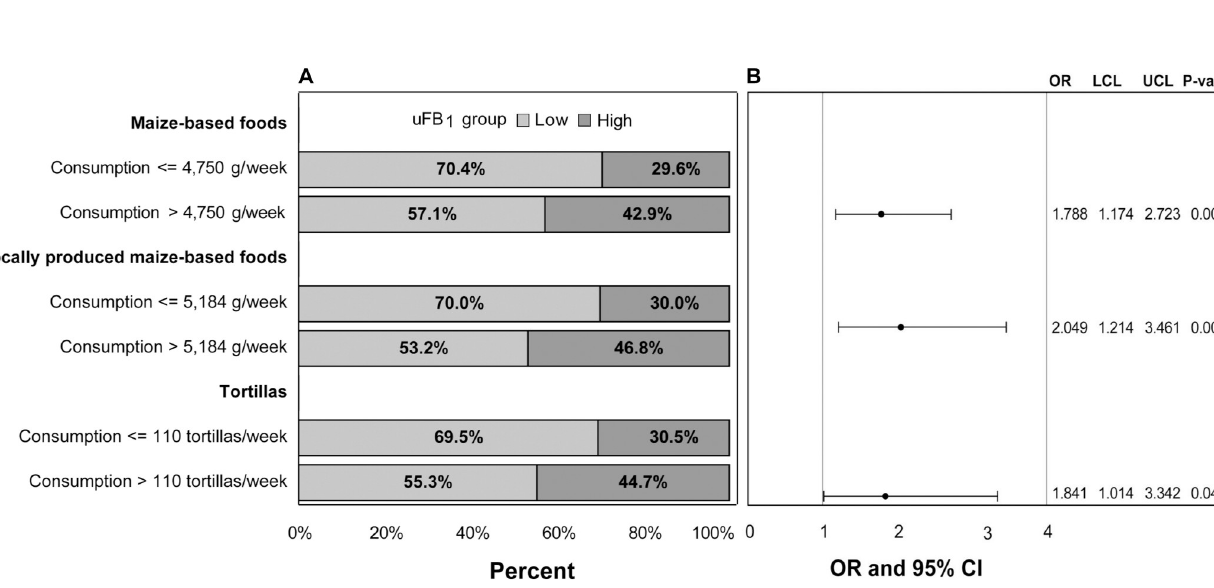
PLOS Global PublicHealth | https://doi.org/10.1371/journal.pgph.0000337 August 9, 2022 11 /